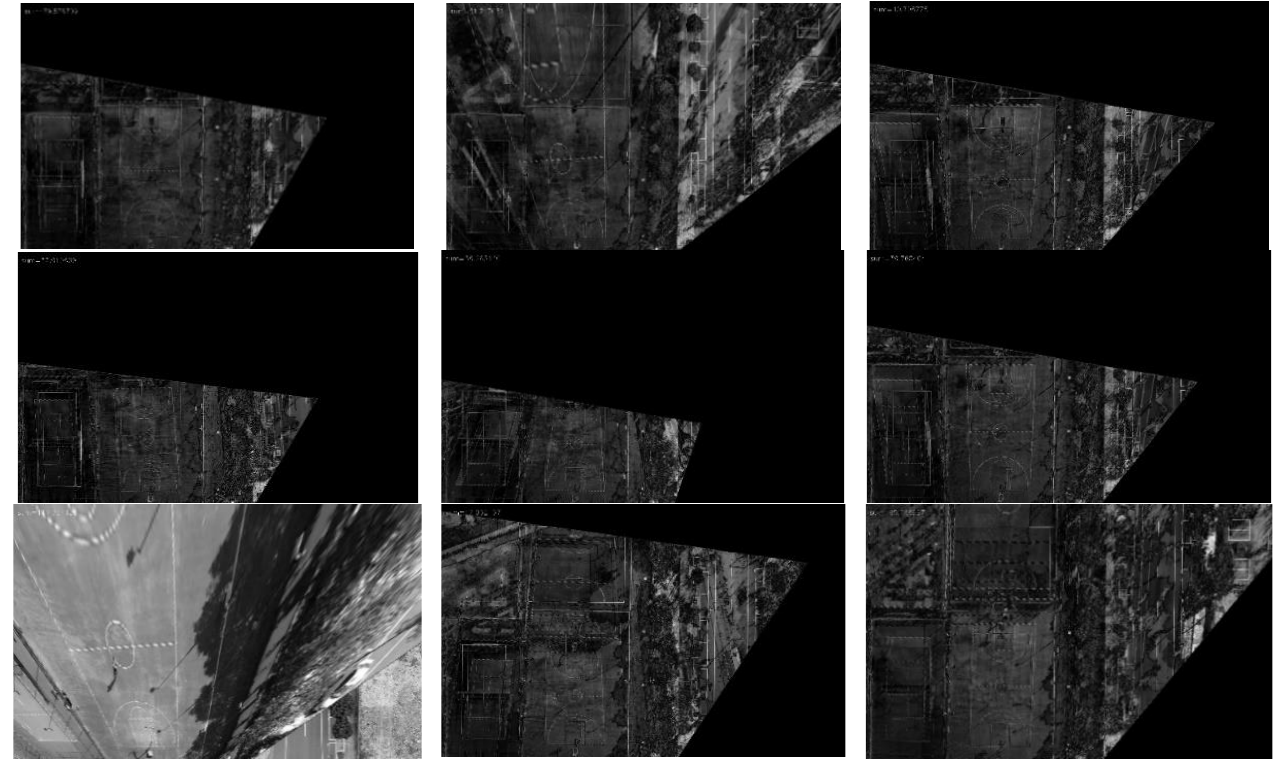
Figure 17. Registration difference image (without updating the map features).